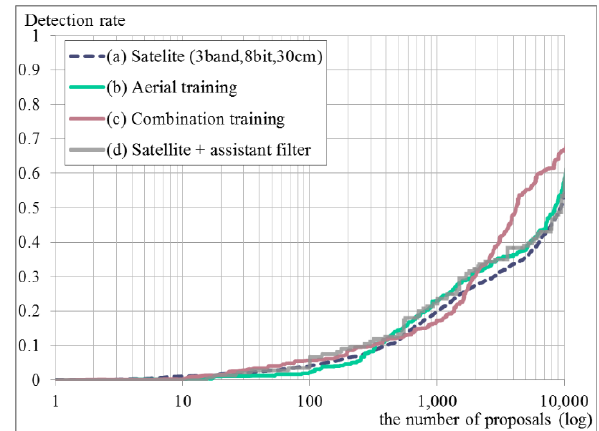
Figure 12. Comparison of detection rate between